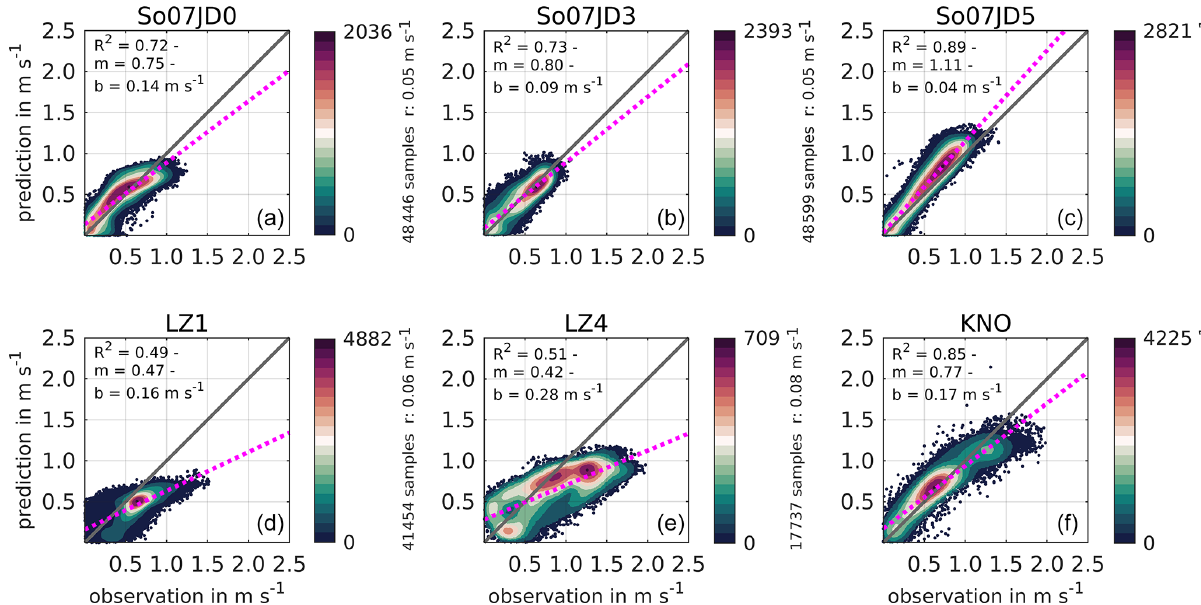
Figure 14. Scatterplots of current velocity magnitude at different gauges in the German Bight in 2012: in So07JD0 (a) , So07JD3 (b) , and So07JD5 (c) in the Jade estuary; in LZ1 (d) and LZ4 (e) in the Elbe estuary; and in KNO (f) in the Ems estuary. Figures are colored according to sample density and contain the index of agreement R 2 as a measure for regression quality and the linear regression slope m and y intercept b in m/s. The dotted pink line represents a linear regression, and the solid black line represents an optimal correlation between observation and